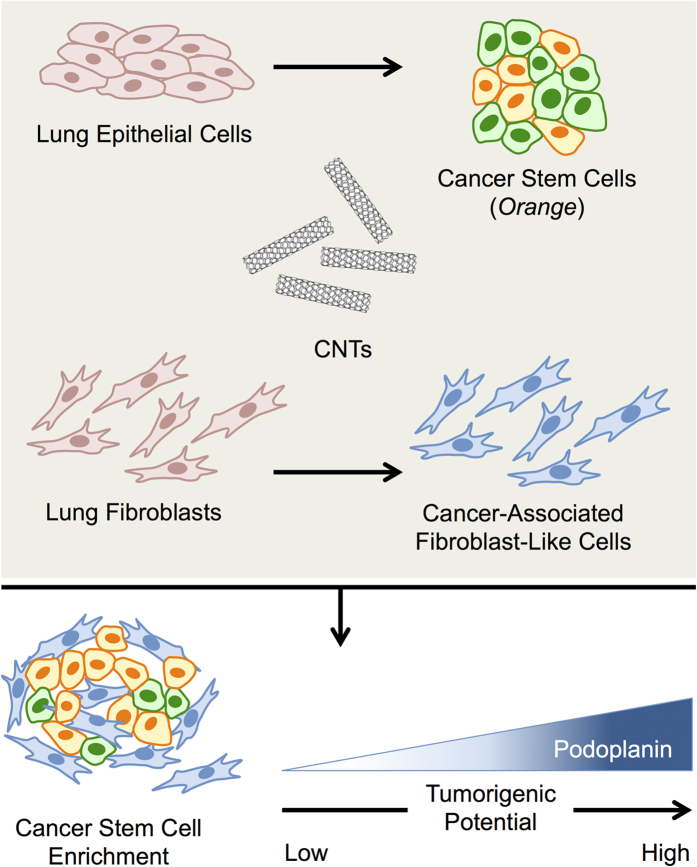
A schematic working model for the roles of carbon nanotubes in tumor promotion.Carbon nanotubes can induce cancer associated fibroblast-like cells that promote cancer stem cell formation in lung epithelial cells.